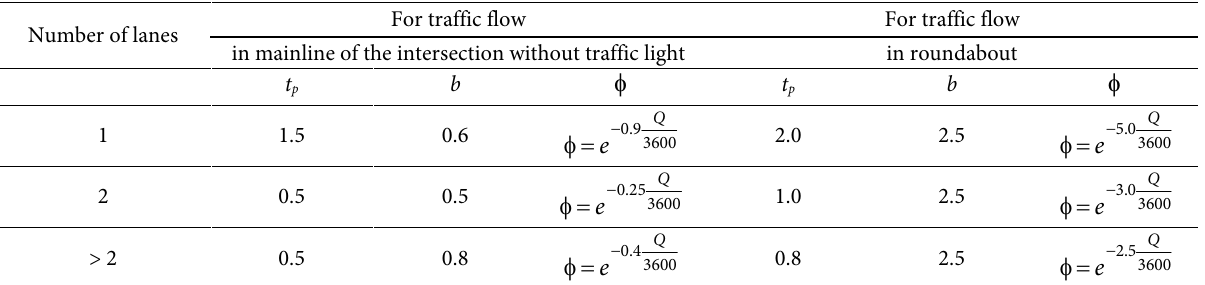
Table 1. Values of parameters in R. Akçelik’s model for evaluation of the proportion of vehicles which move freely (Akçelik 2007; Tanyel, Yayla 2003) For traffic flow For traffic flow Number of lanes in mainline of the intersection without traffic light in